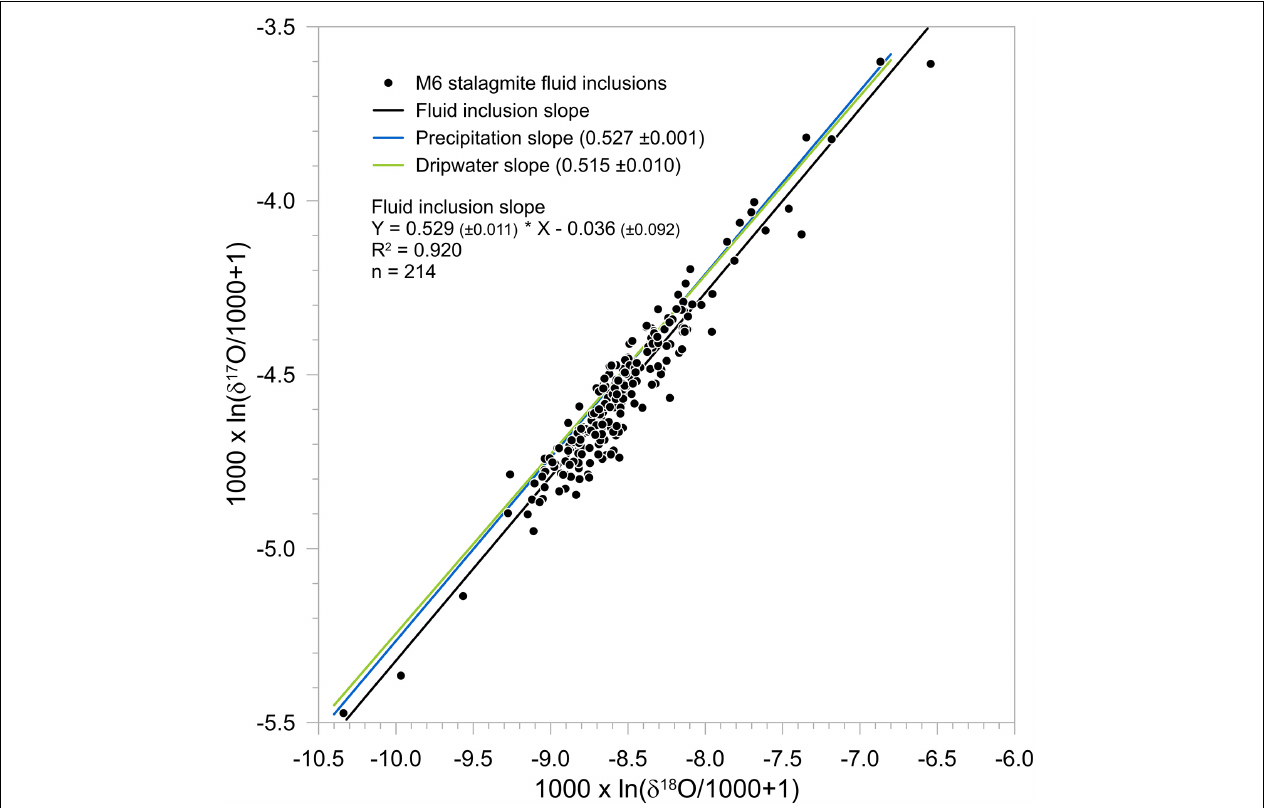
FIGURE 7 | Relationship between δ 17 O and δ 18 O in speleothem fluid inclusion water compared to the slopes of the local meteoric water line in precipitation above the cave and to the drip water in Milandre Cave as measured between 2012 and 2015 (Affolter et al., 2015).